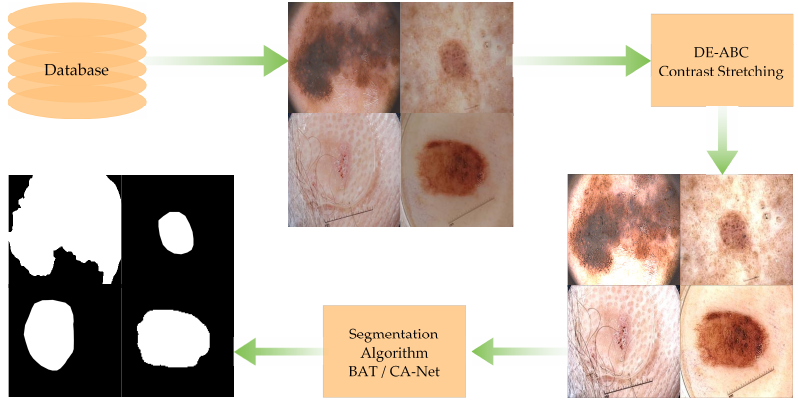
Figure 2. Proposed methodology general flow diagram.